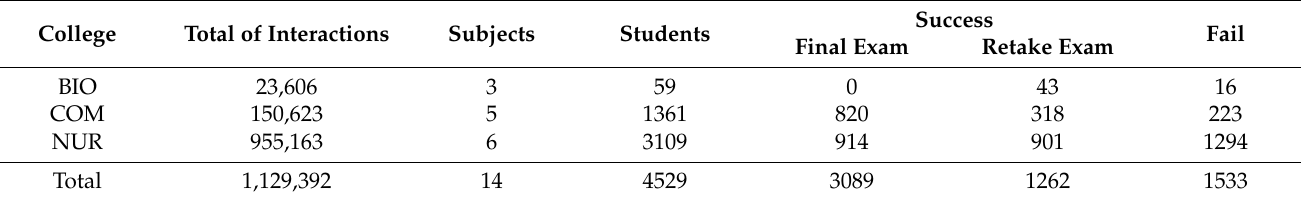
Table 2. Description of the student population and final